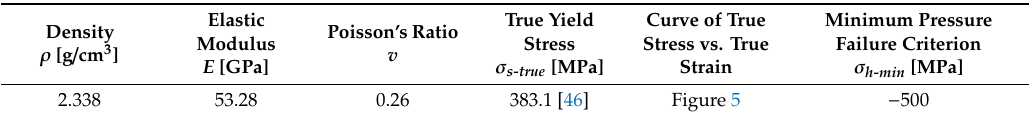
Table 1. Material model parameters for the potassium dihydrogen phosphate (KDP) crystal used in SPH simulations.